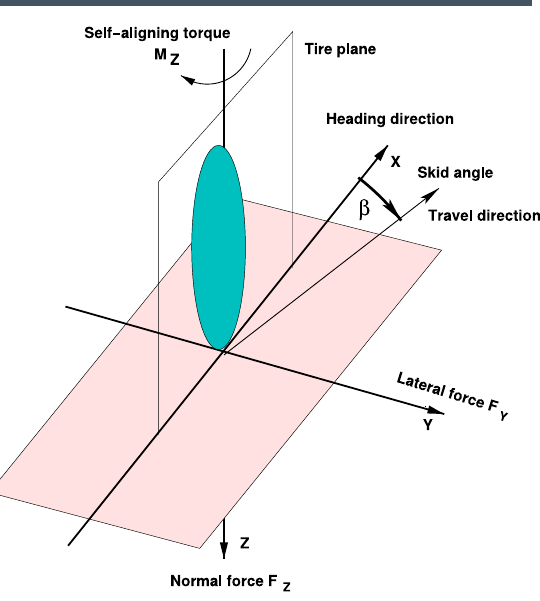
Figure 1. F Y and M z definitions [39].